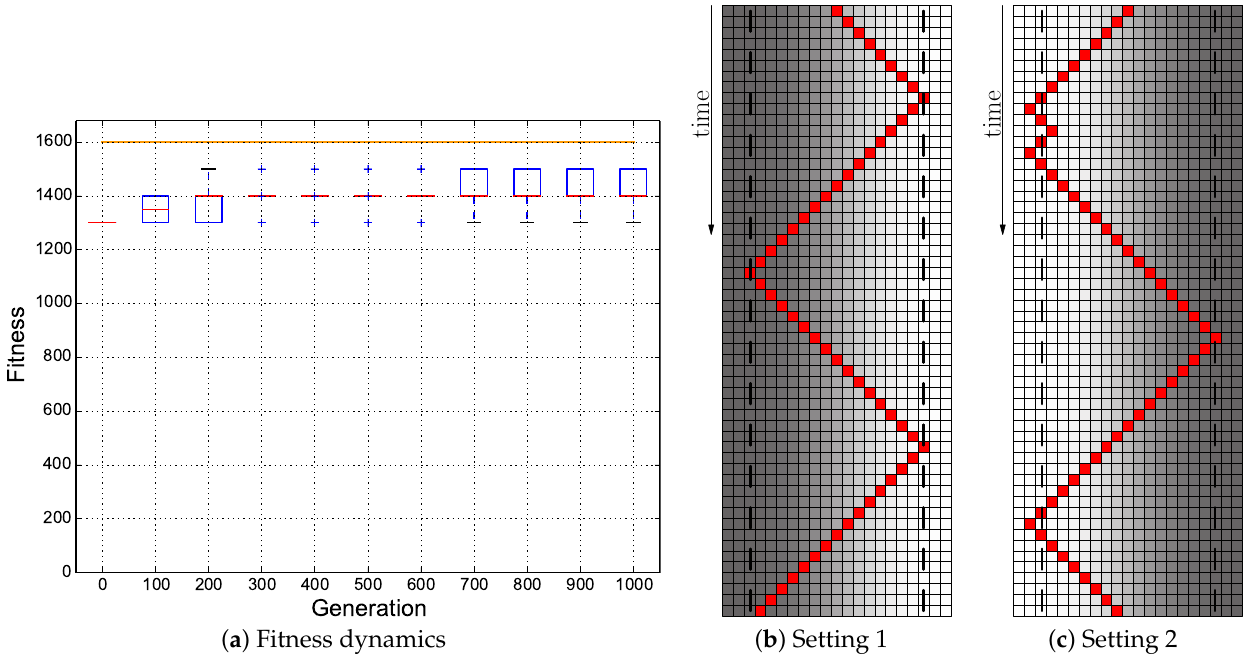
Figure 15. Evolutionary results of the Instant + Switch fitness regime starting with the hand-coded ANN (Figure 5a): fitness = F ( 100,0,0.01 ) ; the minimum of both evaluations was used as the fitness value for each genome. ( a ) Fitness dynamics of the evolutionary population. The horizontal orange line indicates the maximum fitness achievable by a reactive Wankelmut controller. ( b , c ) Trajectory of the best performing genome in both environmental